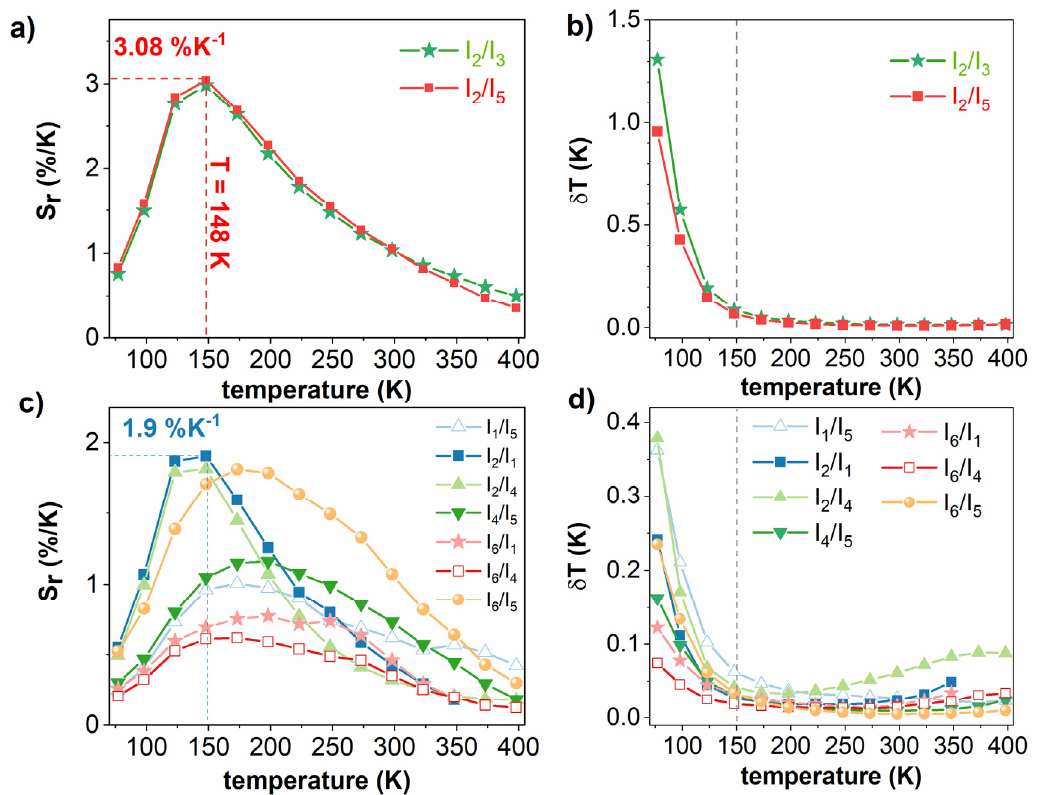
Figure 9. Relative sensitivities (S r ) and temperature uncertainties ( δ T) derived from thermometric parameters based on thermally coupled levels ( a , b ) and uncoupled levels ( c , d ).